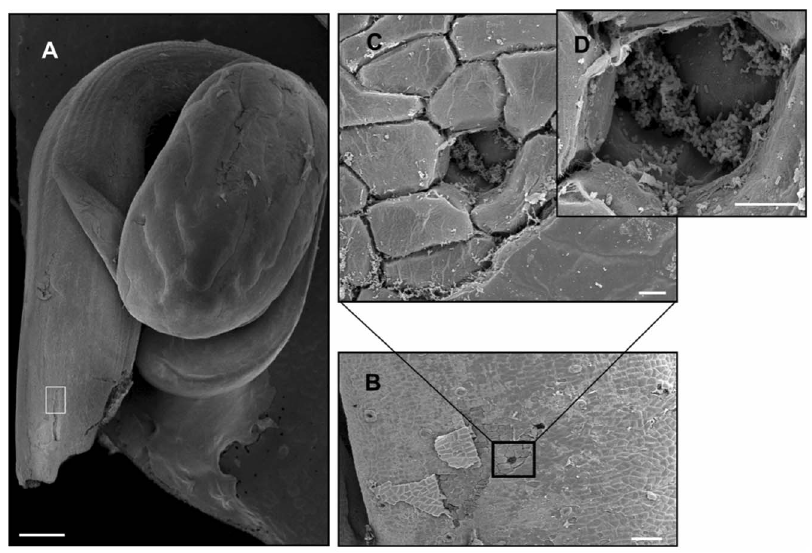
Fig. 1. Scanning electron microscopy of a bean sprout inoculated with L. monocytogenes . Sterile bean sprouts were placed in HTM agar media with 3% glucose and inoculated with 10 m l of a 1:10 dilution of a 24- hour culture of 10403S. Following a 24 hour incubation, bean sprouts were processed for scanning electron microscopy (A) Bean sprout (bar 5 1 mm) (B) magnified view of the white square from (A) (bar 5 100 m m). (C) Bean sprout vegetative tissue colonized with L. monocytogenes (bar 5 10 m m) (D) magnification of (C) (bar 5 10 m m). (Fig. 1D). To further visualize EPS production by L. monocytogenes during bacterial growth in biofilms, transmission electron microscopy (TEM) of biofilms formed on regenerated cellulose and planktonic bacteria grown in broth culture